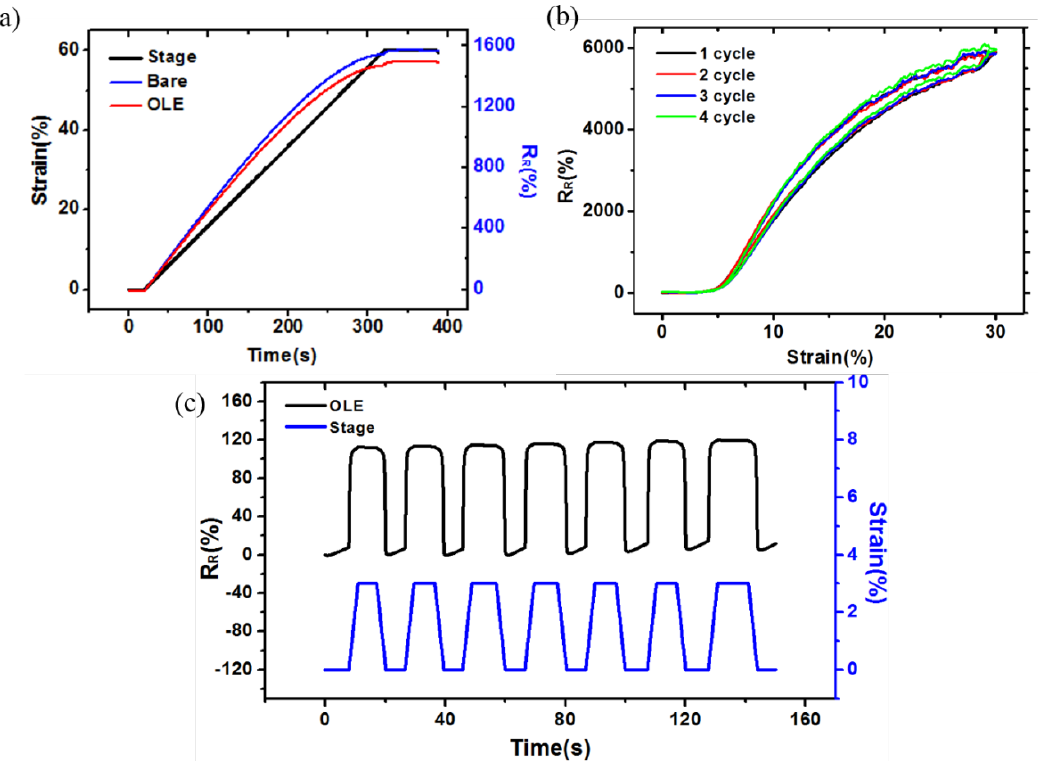
Figure 7. ( a ) Performance comparison between an OLE sensor and a bare sensor at 60% strain; ( b ) hysteresis at 30% strain; and ( c ) repetition experiment at low strain (0~3%).